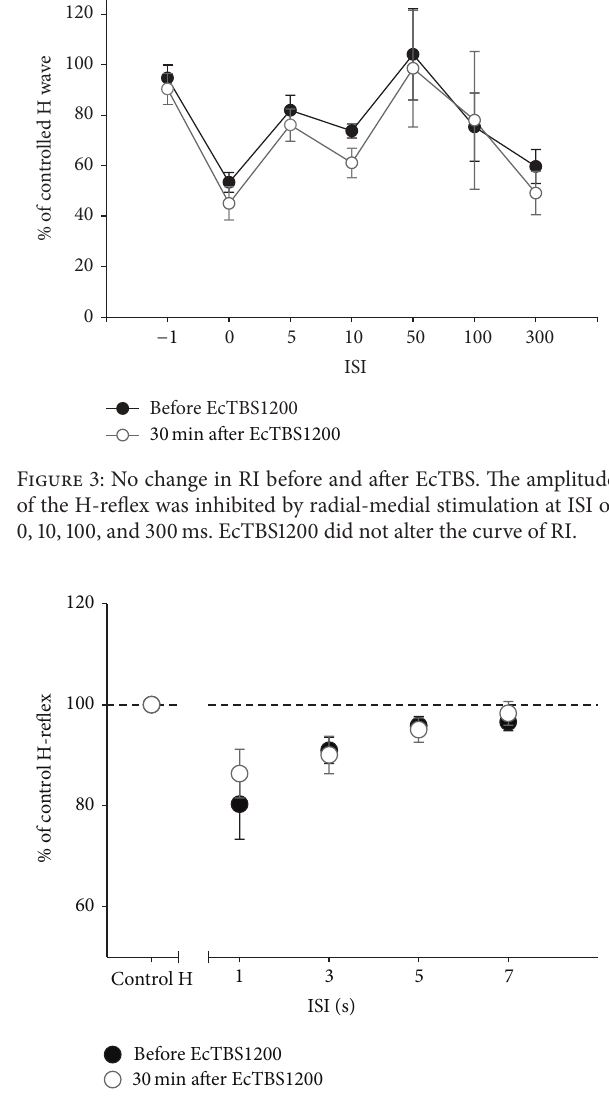
Figure 4: PAD was not changed by EcTBS1200. No significant dif- ference was found in PAD before and after EcTBS1200. Additionally, the depression effect of PAD became nonsignificant after 5